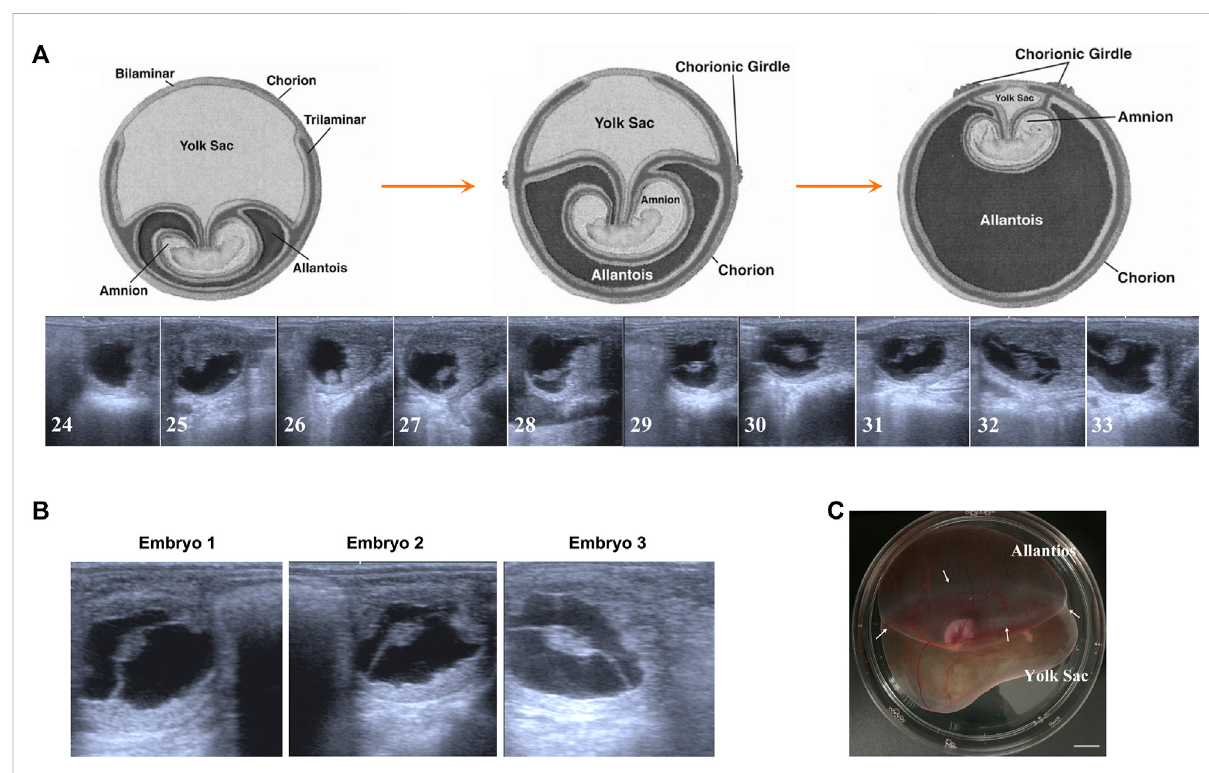
EarlygestationdevelopmentofMongolianhorse. (A) Theultrasonographicimagesofembryosfromday24 stoday33. (B) Theultrasonographic image of day 30 embryos we used in this study. (C) Photo of day 30 equine embryo, white arrows show the chorion girdle, bar = 1